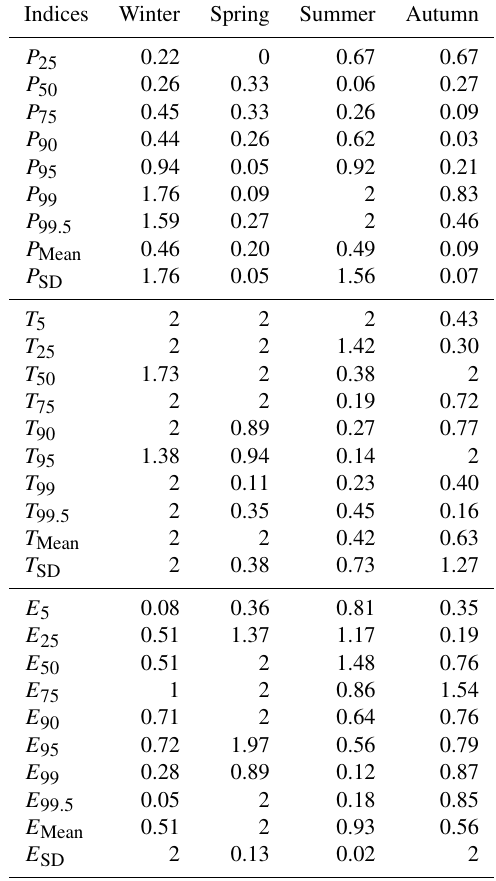
Table 3. R index values for the variables for 1970–1989 as historical period and 1998–2017 as future period.